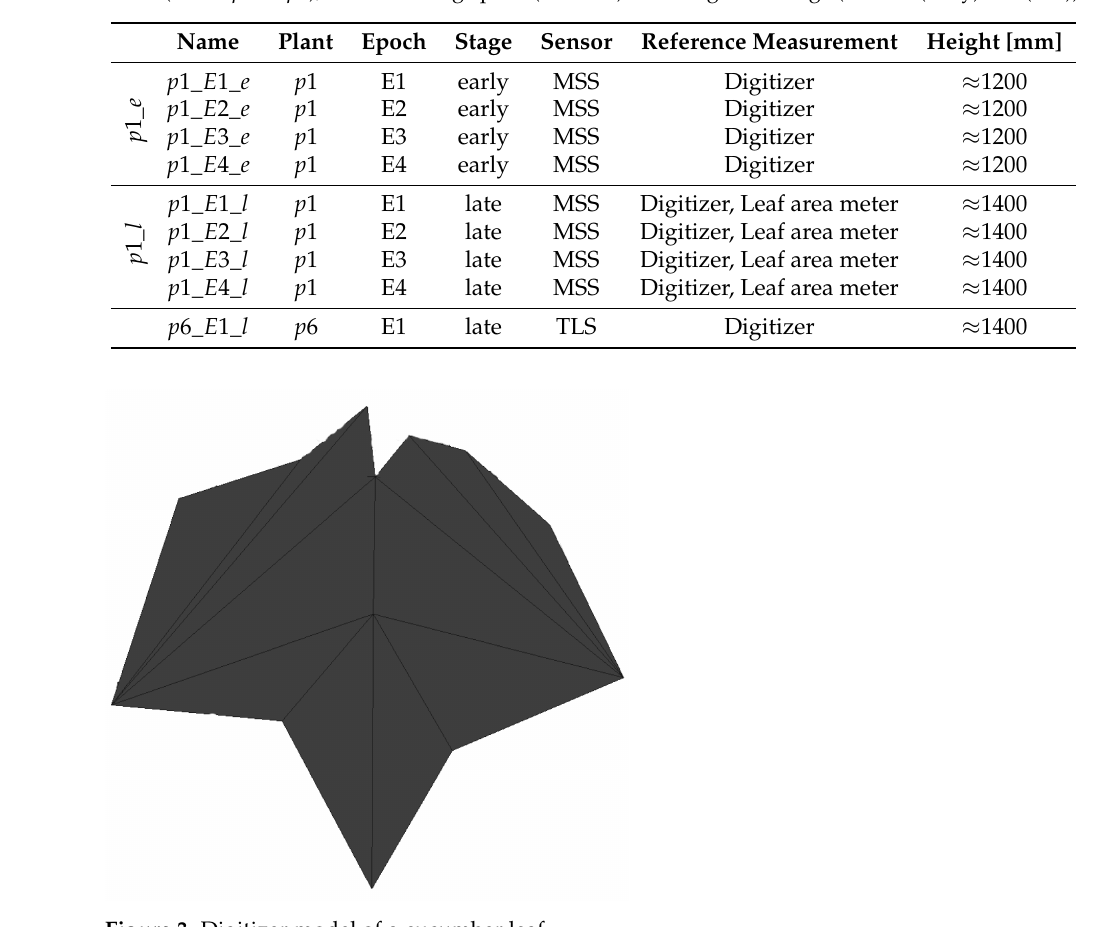
Figure 3. Digitizer model of a cucumber